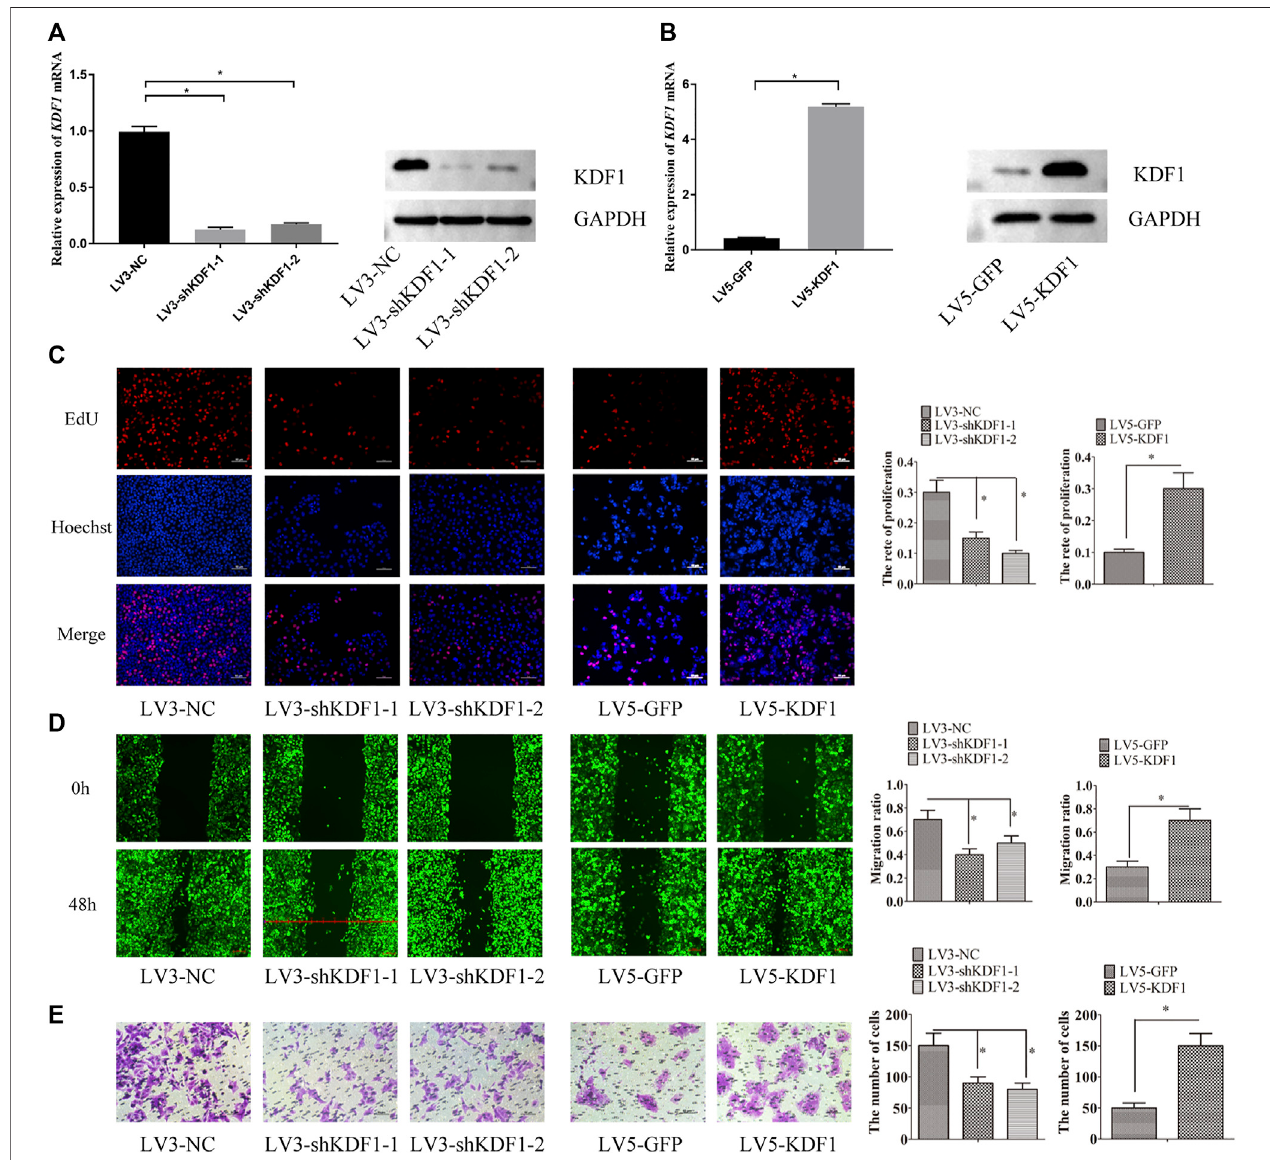
FIGURE 5 | KDF1 promoted proliferation, migration, and invasion of ovarian cancer cells. KDF1 protein expression examined by Western blot (A,B) . The cell proliferationabilitywasdetectedbyEdUassay (C) .Thecellmigrationabilitywasdetectedbywoundscratchassay (D) .Thecellinvasionabilitywasdetectedbytranswell assay. Error bars represent the standard error (E) . *indicates p <